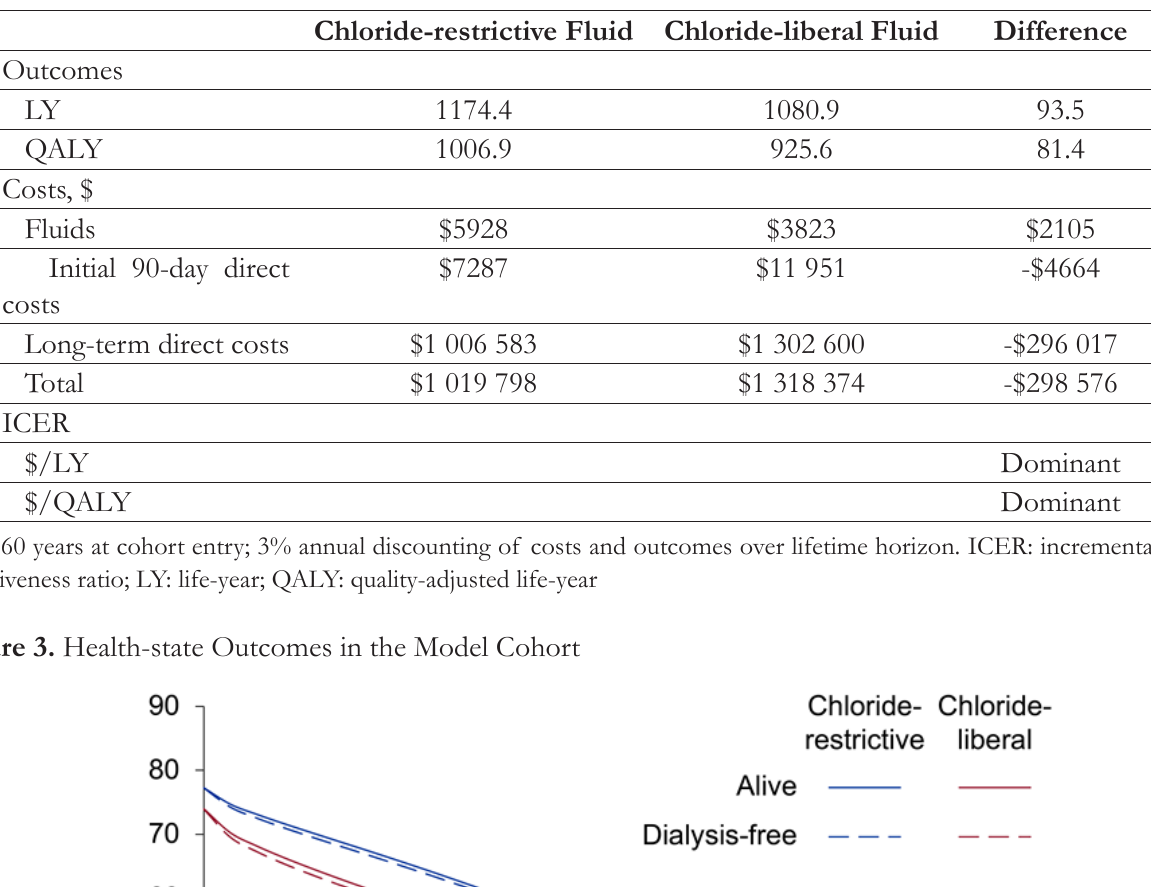
Table 1. Base-case* Cost-effectiveness Results (per 100 patients)